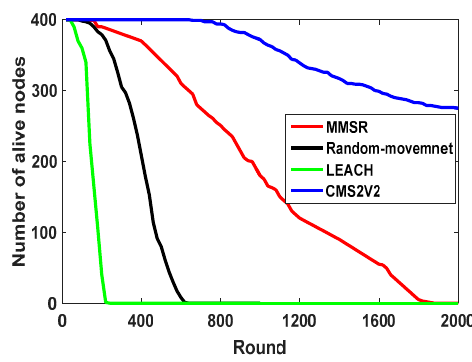
Figure 11 . Number of alive nodes comparison.